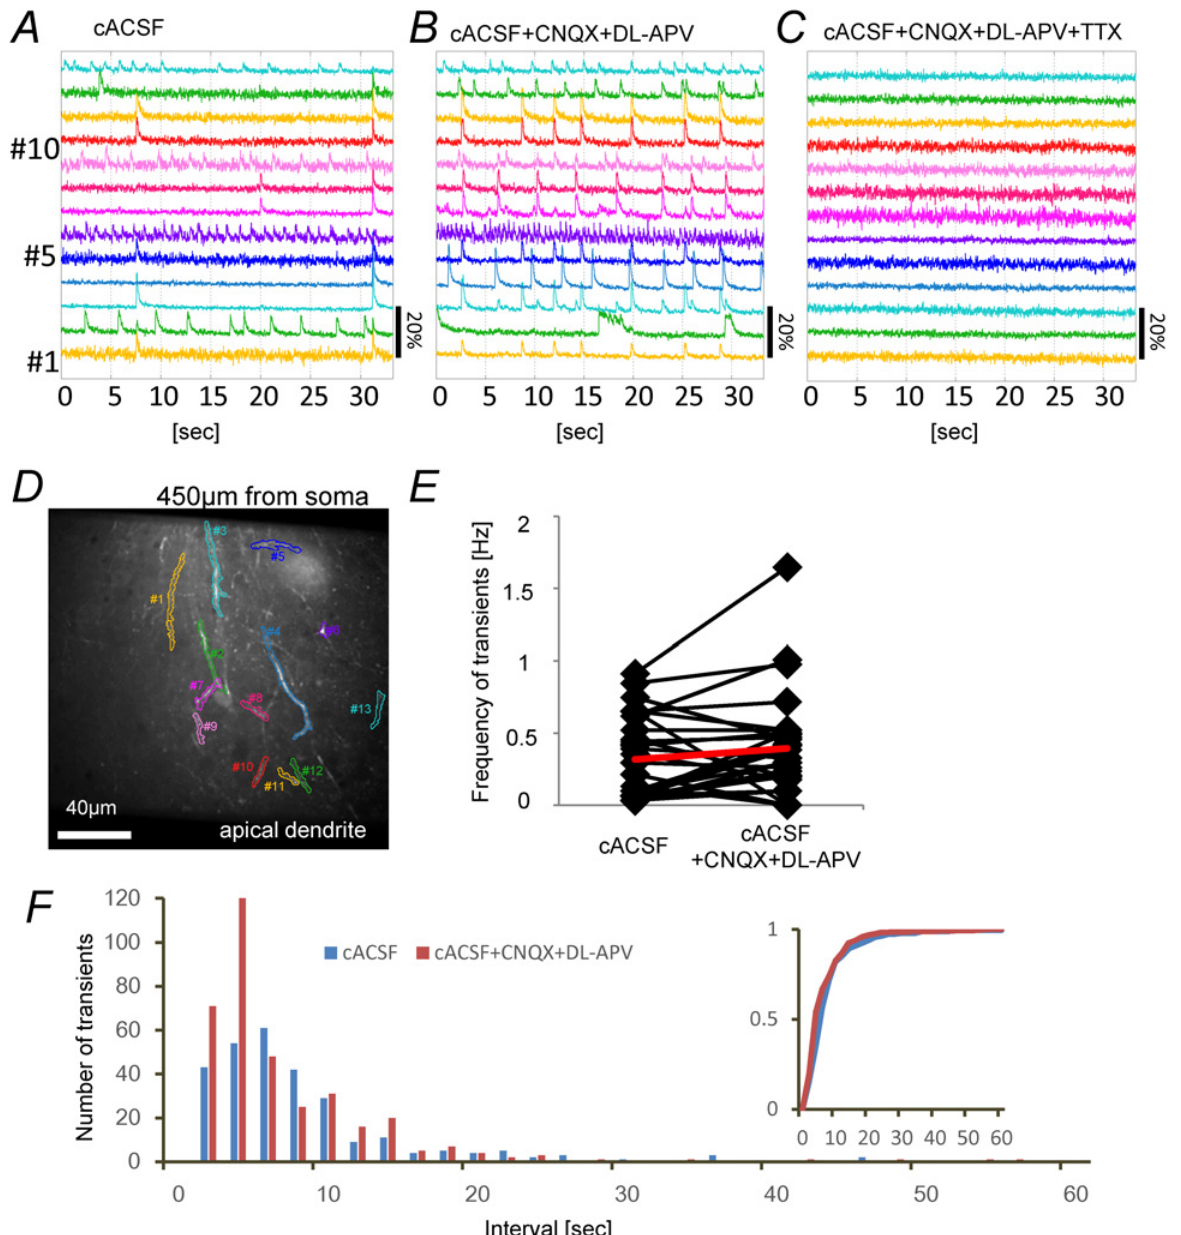
Fig 5. Pharmacological characterization of spontaneous fast-Ca-transients. ( A ) — ( C ) Fast-Ca-transients recorded from the distal apical dendrites of the same preparation. ( A ) In cACSF with 3.5 mM K + ion. ( B ), In cACSF containing 10 μ M CNQX and 50 μ M DL-APV ( C ). In the presence of 1 μ M TTX added to the solution used in ( B ). Scale bar ( Δ F/F): 20%. The recordings in ( B ) and ( C ) were made 15 minutes after switching the solution. ( D ) ROIs for panels ( A ) — ( C ). To allow comparison, the same ROIs were used throughout. The center of the image field was 450 μ m from the border between the cell layer and the str. pyramidale. ( E ) Frequency of the fast-Ca-transients in 24 ROIs in the absence or presence of CNQX and DL-APV; the red line shows the mean values. There was slight increase in frequency in the presence of CNQX and DL-APV (153 ± 256%), but the change was not significant (Wilcoxon signed-rank test P > 0.05, 4 slices, 24 ROIs). ( F ) Interval histogram of fast-Ca-transients in 24 ROIs in the absence or presence of CNQX and DL-APV constructed using the same set of data used for panel E ; the blue bars show number of transient-intervals in cACSF, red bars show number of transient-intervals in the presence of CNQX and DL-APV (bin width: 2 sec). Inset shows the cumulative fraction of transient-intervals.